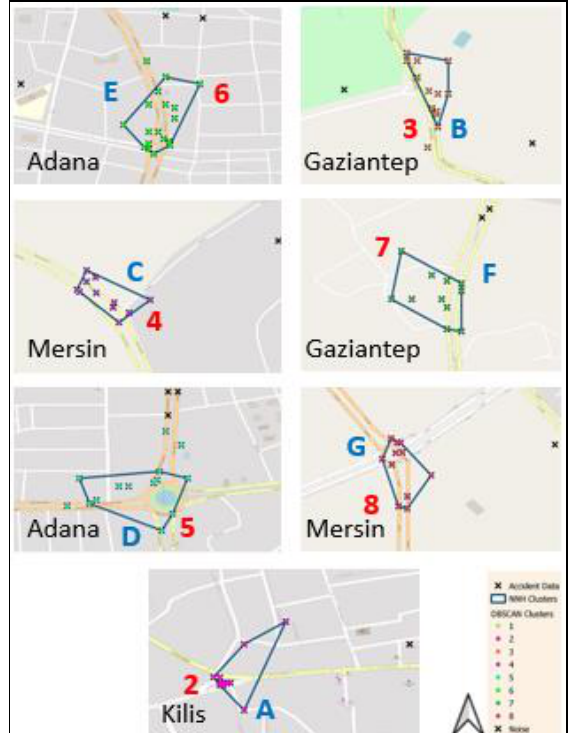
Figure 5. Mersin Region Speed-related Accident Clusters Map of 2016-2017 (NNH and DBSCAN are